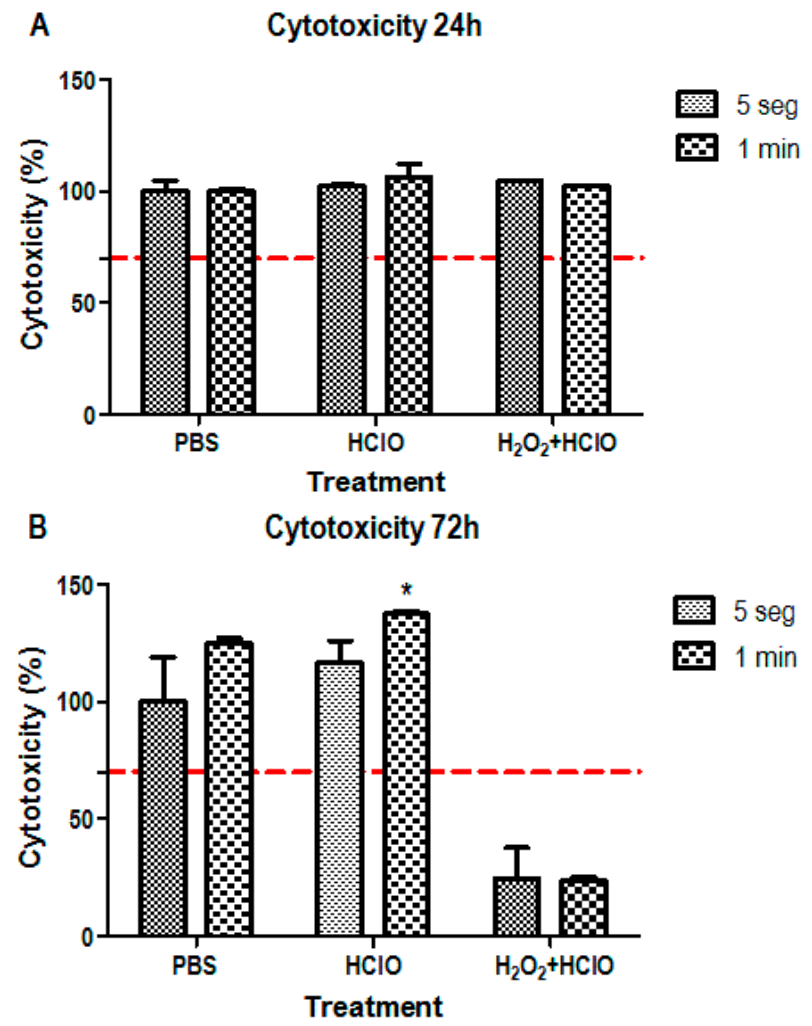
Figure 5. Cytotoxicity levels of SAOS-2 cells. Cultures performed at 24 h ( A ) and 72 h ( B ) incubating the discs in the treatment solution for 5 s and for 1 min. The treatments used were hypochlorous acid (HClO) and hydrogen peroxide (H 2 O 2 ) + HClO, using a PBS treatment as control. * p < 0.05. The red line indicates the minimum level for cytocompatibility.